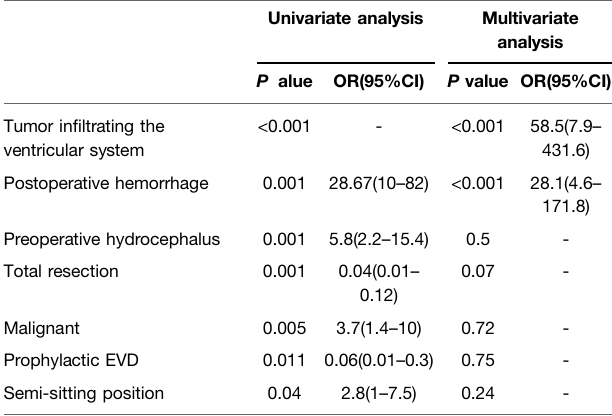
TABLE 6 | Summary of the factors with postoperative VP shunt placement. TABLE 7 | Univariate and multivariate analyses of the association between postoperative VP shunt placement and factors.